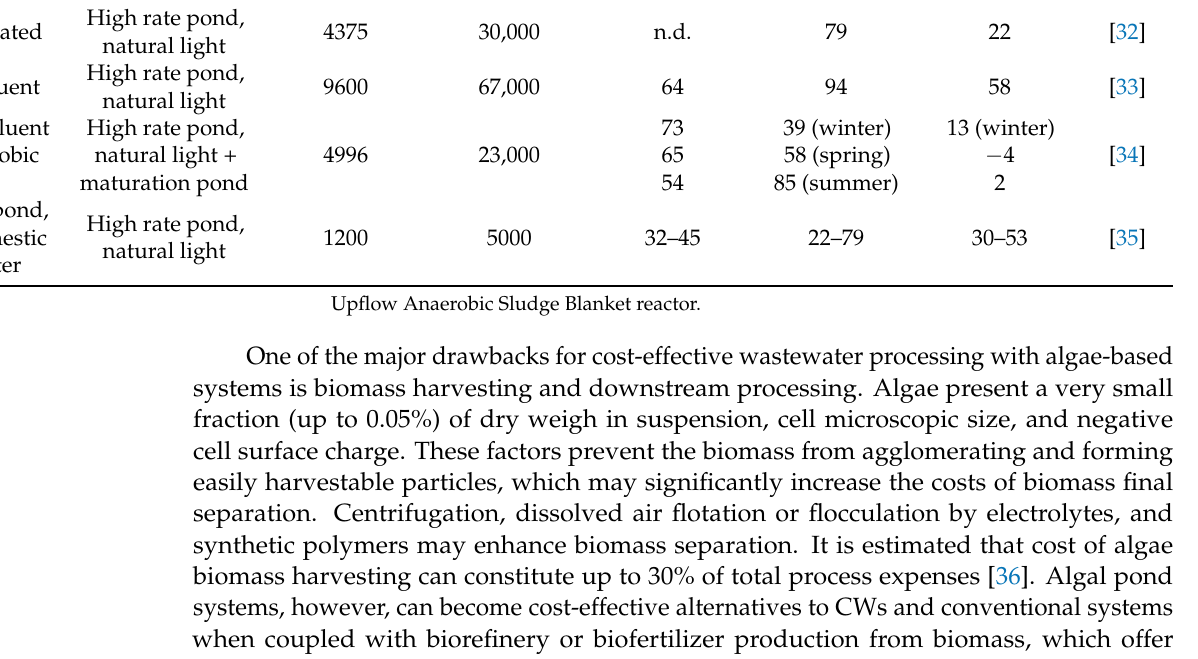
Table 1. Microalgae removal for C, N, and P from municipal wastewater in full-scale facilities. Substrate